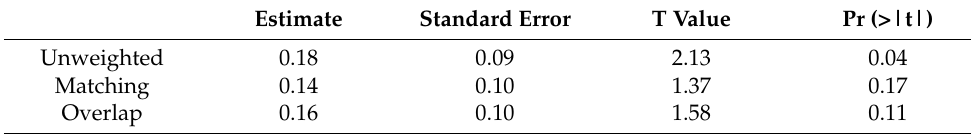
Table 3. Comparison of 90-day survival between remdesivir and control cohorts .